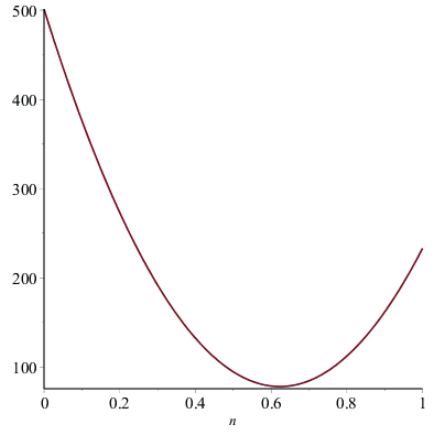
Figure 6: Plot of M